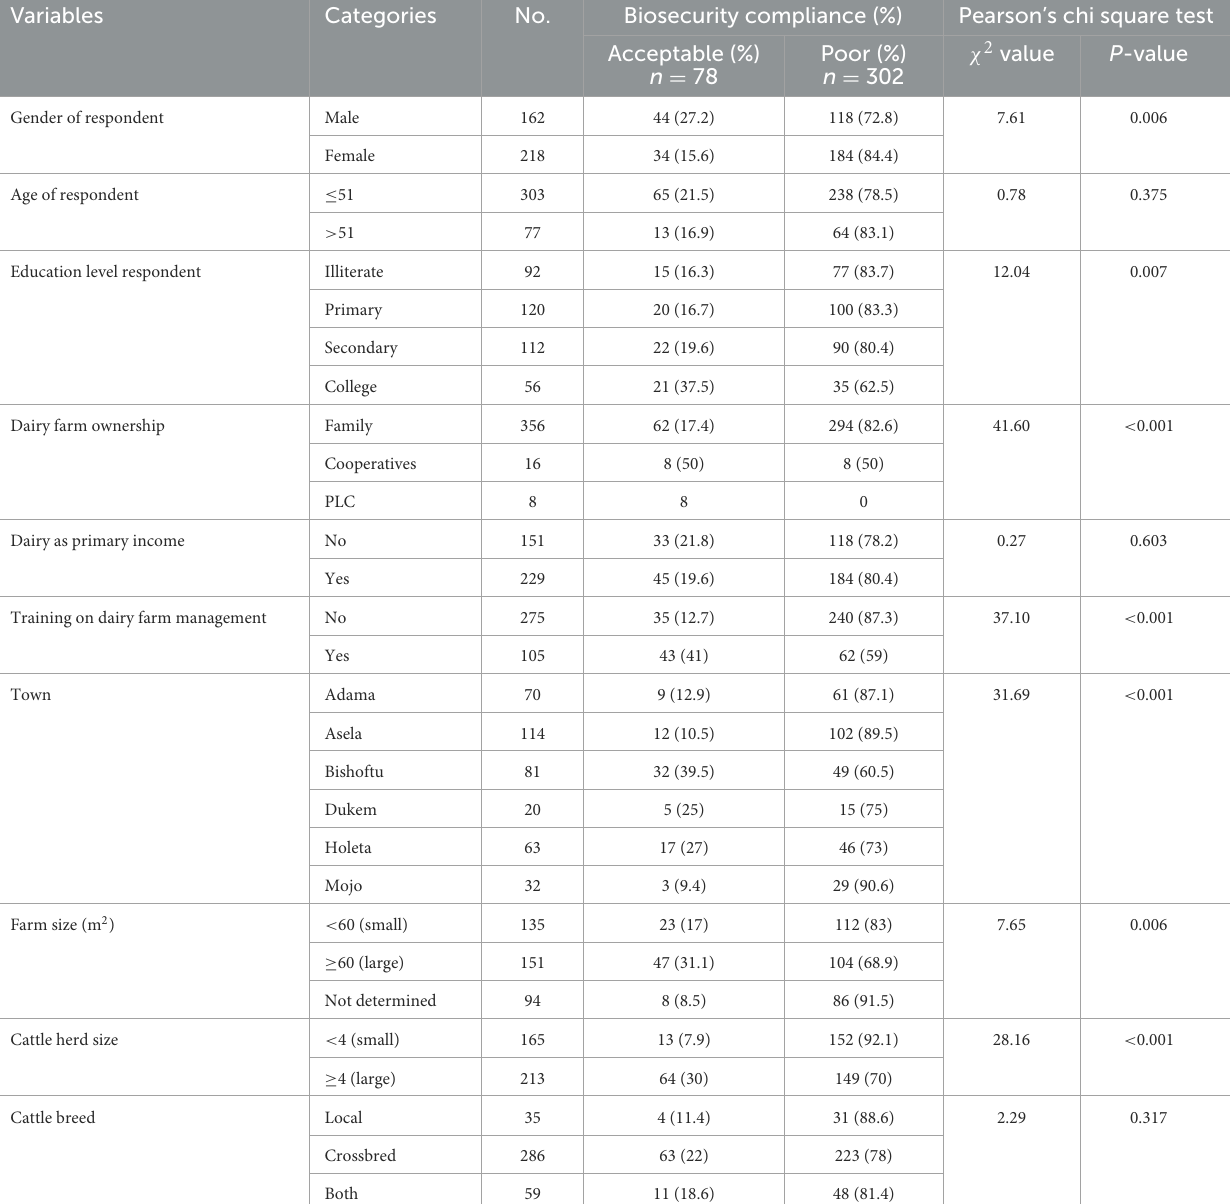
TABLE 6 Association between sociodemographic variables and dairy farm biosecurity status.